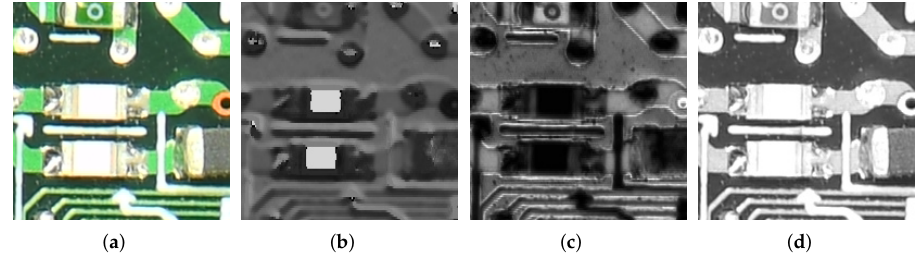
Figure 5. ( a ) The original PCB image; ( b ) H channel of the image; ( c ) S channel of the image; ( d ) V channel of the